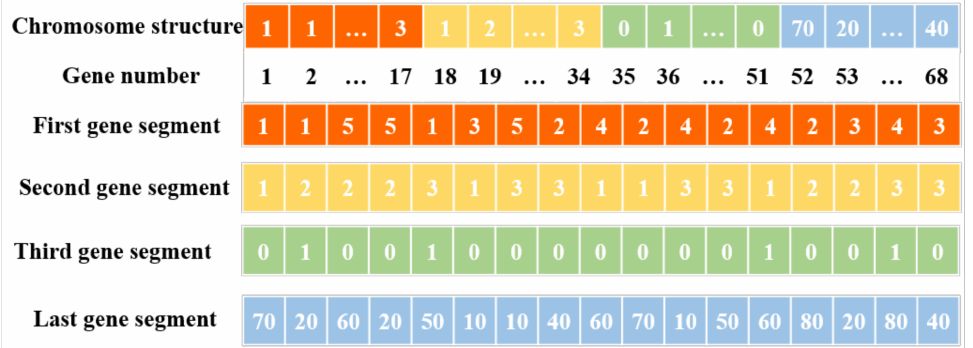
Figure 6. A randomly generated chromosome and the gene